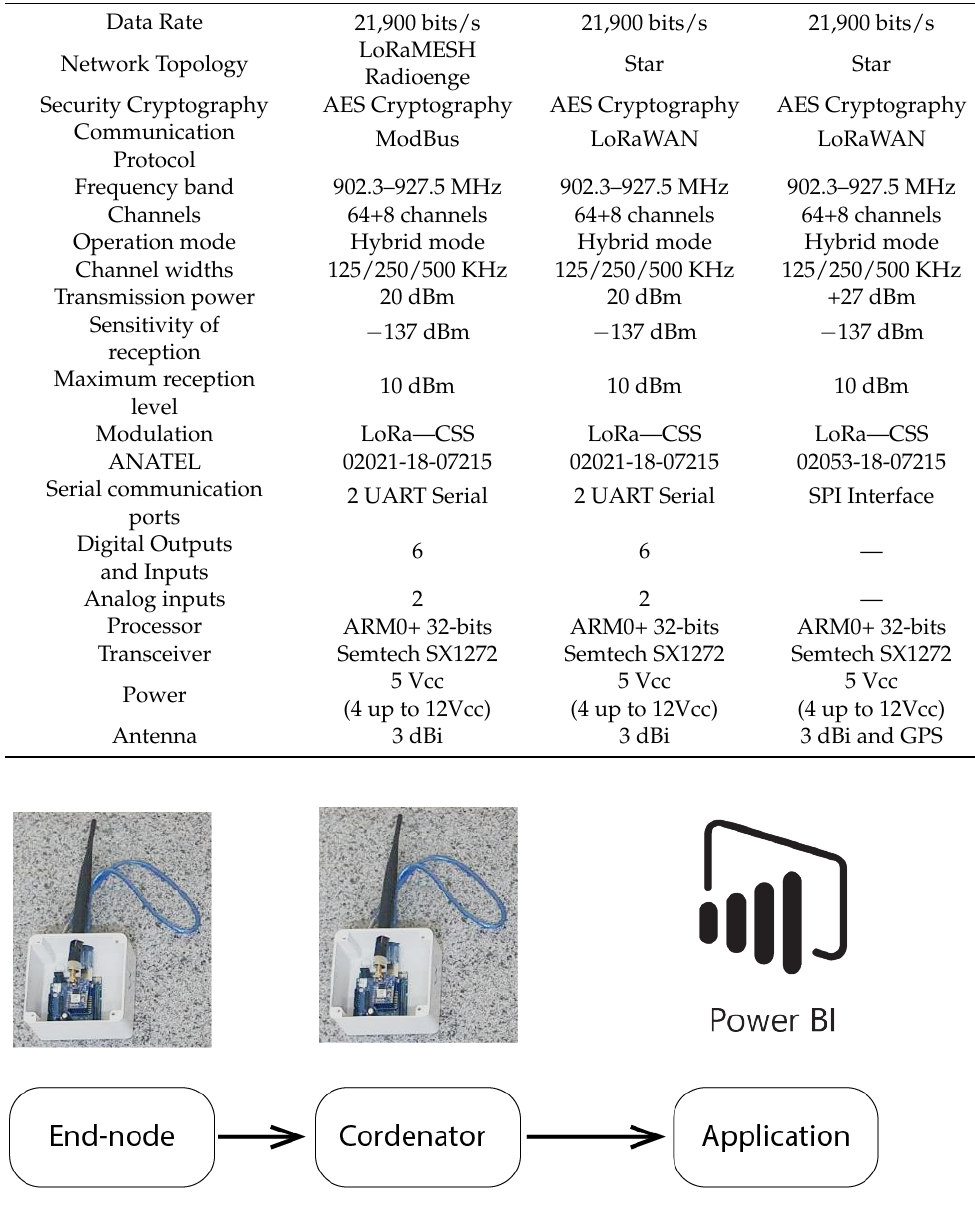
Figure 13. LoRaMESH